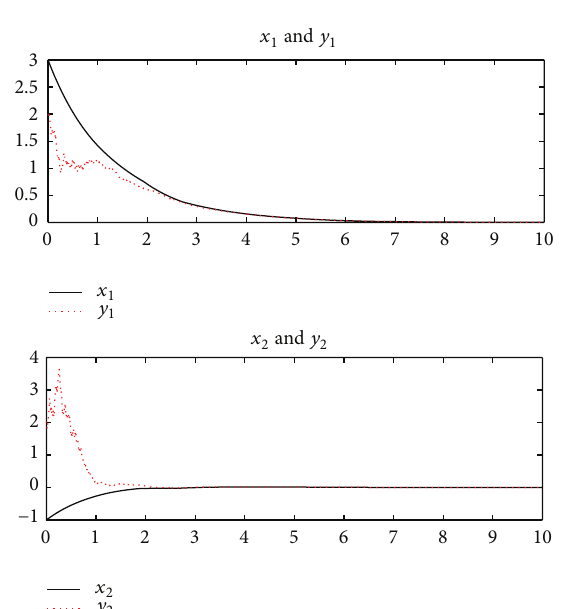
Figure 1: 2-state Markov chain.